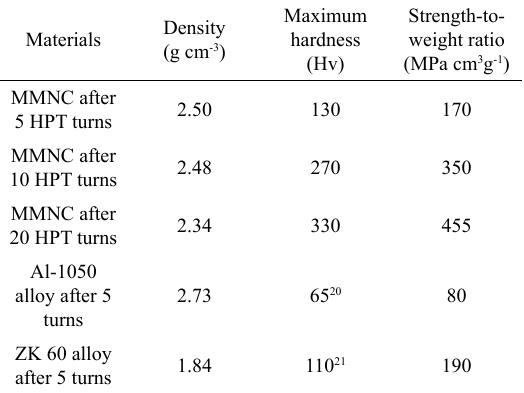
Figure 5. An OM micrograph (upper) and a color-coded contour map of the Vickers microhardness (lower) for the vertical cross-sectional plane of the Al-Mg disks after HPT for 20 turns at room temperature under a pressure of 6.0 GPa. 34 was recorded at the vertical cross-section of the processed Table 1. The measured density, the maximum Vickers hardness value, and the estimated strength-to-weight ratio for the MMNCs in the disk where the results of the micrograph and the color-coded Al-Mg system after HPT for 5-20 turns and the reference materials hardness map are shown in Fig. 5. 34 of Al-1050 and ZK60 alloys after HPT for 5